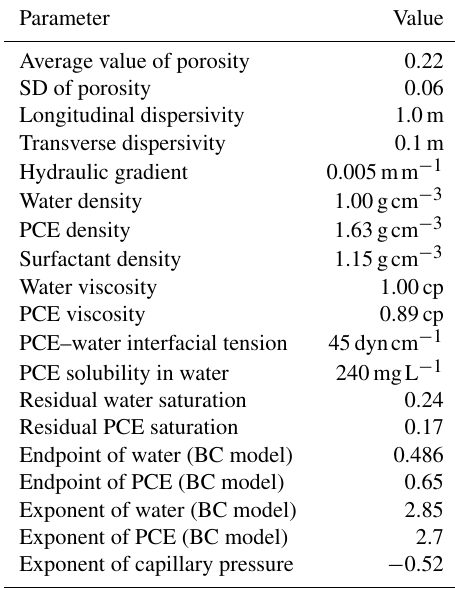
Table 1. Parameters used in the